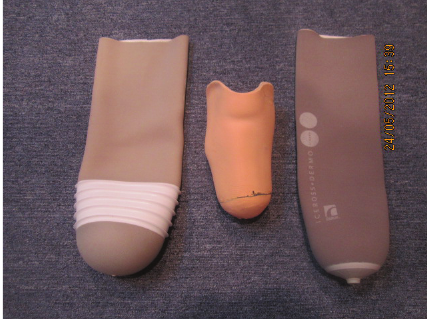
Table 1: Characteristics of the participants.